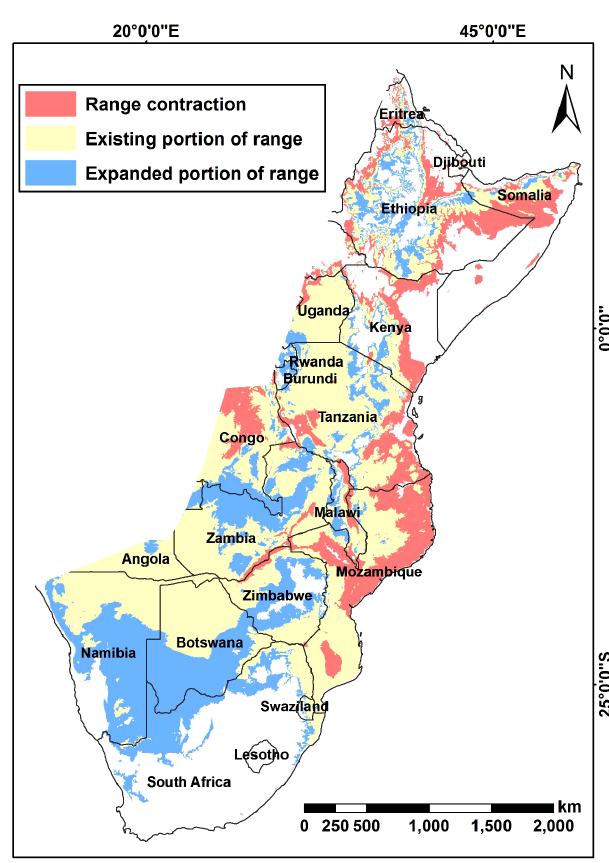
Fig. 1 . Map recreated from data in Moore et al. (2012). It shows the suitable geographical range for Trypanosoma brucei rhodesiense (assuming presence of their vector, tsetse flies) in 2055. The yellow region represents the portion of the predicted future range where the parasite currently exists. The blue area represents the portion of the predicted future range where the parasite does not currently exist and would therefore be expanding into. The pink areas on the map represent currently suitable areas predicted to be too hot for the parasite under future conditions. Additional details on methodology used to create the map can be found in Moore et al. (2012). Although T.b. rhodesiense is responsible for human sleeping sickness and not bovine trypanosomosis, we assume that other Trypanosoma species have similar sensitivities to temperature as T.b. rhodesiense . Indeed, Moore et al. (2012) used some parameters from studies on T. vivax , T. congolense , and T.b. gambiense to model the future distribution of T.b. rhodesiense . Although the future distributions of Trypanosoma species might differ from the predicted changes in the distribution of T. b. rhodesiense shown here, we expect large-scale, climate- induced range shifts in bovine trypanosomosis to occur with consequences on cattle production and beef trade in the region.